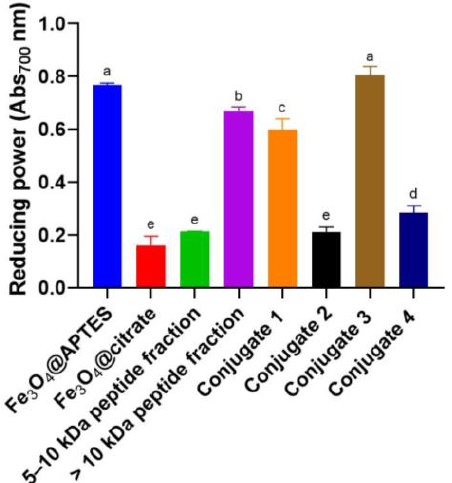
Figure 7. Average results of the RPs of coated magnetite (Fe 3 O 4 @APTES and Fe 3 O 4 @citrate) and of the conjugates and nonconjugated peptide fractions at 15 mg/mL: Fe 3 O 4 @citrate@ > 10 kDa (conjugate 1), Fe 3 O 4 @citrate@ 5–10 kDa (conjugate 2), Fe 3 O 4 @APTES@ > 10 kDa (conjugate 3), Fe 3 O 4 @APTES@ 5–10 kDa (conjugate 4), and nonconjugated peptide fractions (>10 kDa and 5–10 kDa peptide fractions). The determinations were carried out in triplicate. The results are expressed as the means ± standard deviation. Different letters indicate statistical difference between the samples ( p ≤ 0.05).